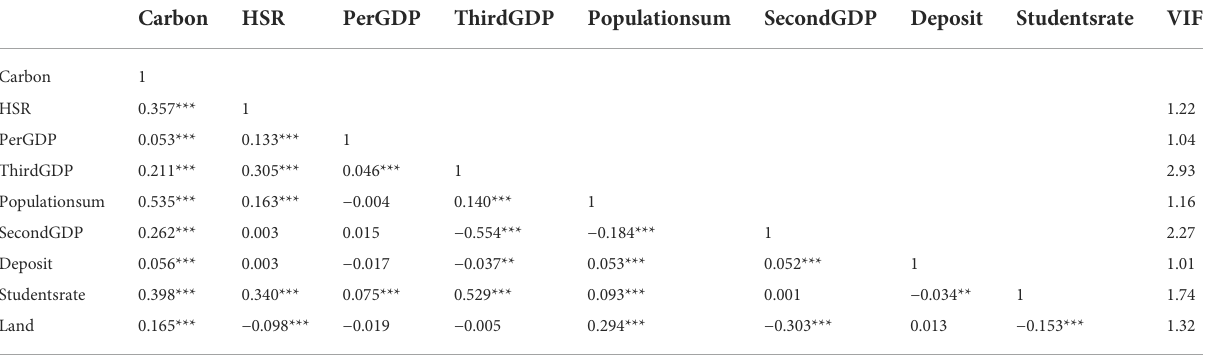
TABLE 3 Correlation